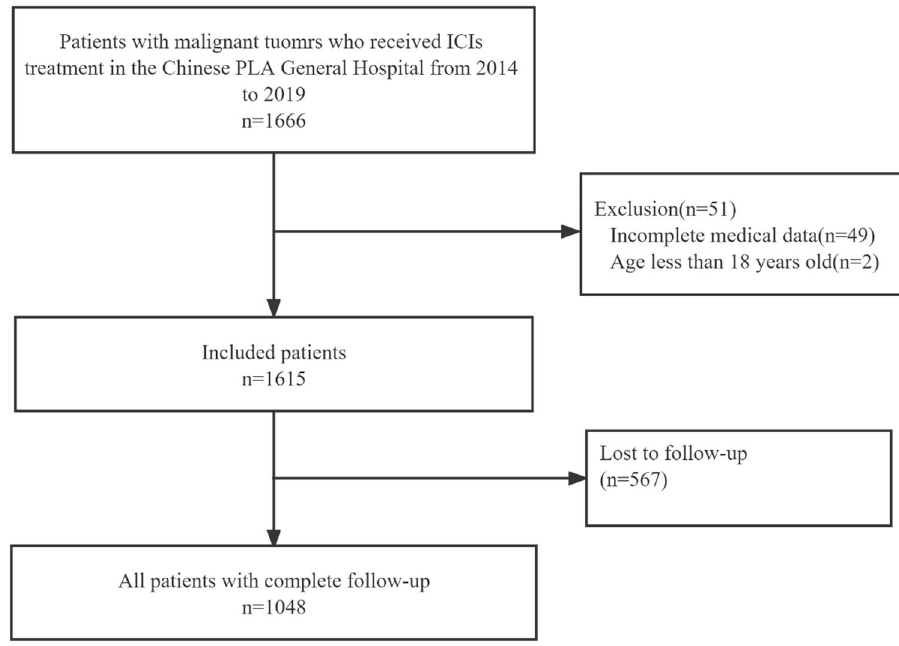
Figure 1. Flow chart of this